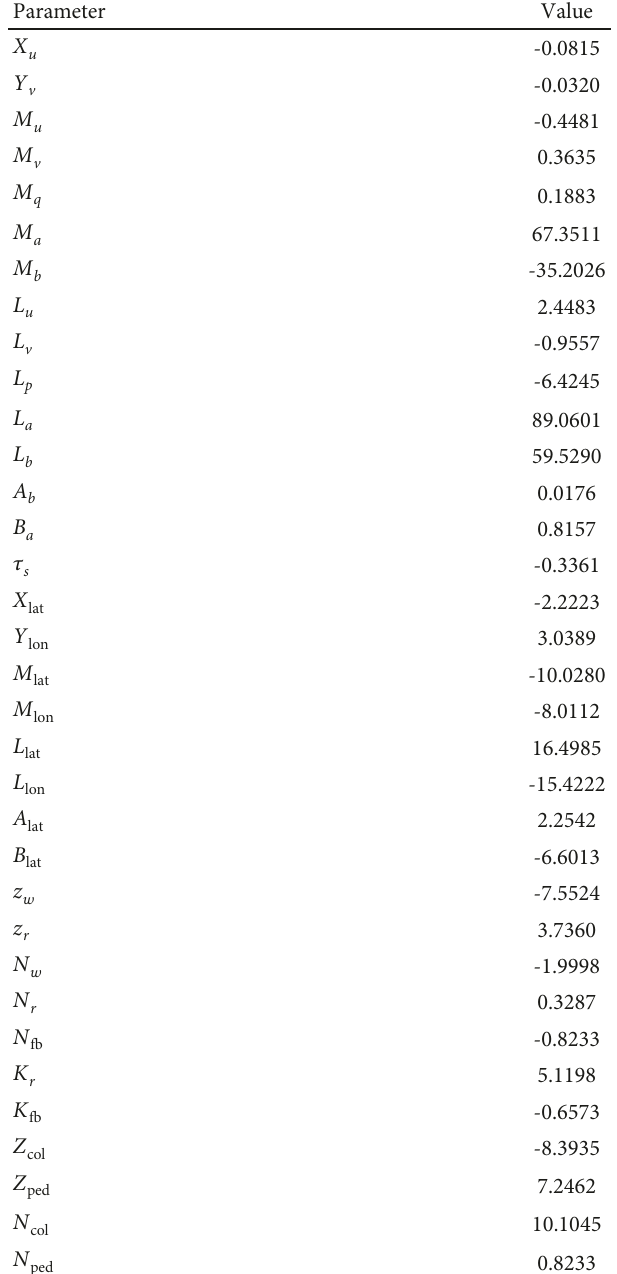
Table 3: The values of the estimated parameters.